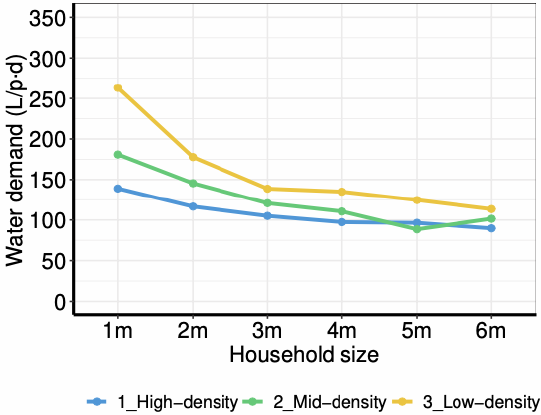
Figure 1. Simulated average water use depending on the size and housing type of the household Although the three housing types show economies of scale, the low-density housing is the one that exhibits a stronger decrease in the water use per capita due to outdoor uses. Note that the shape of the curves match the shape of equational models.